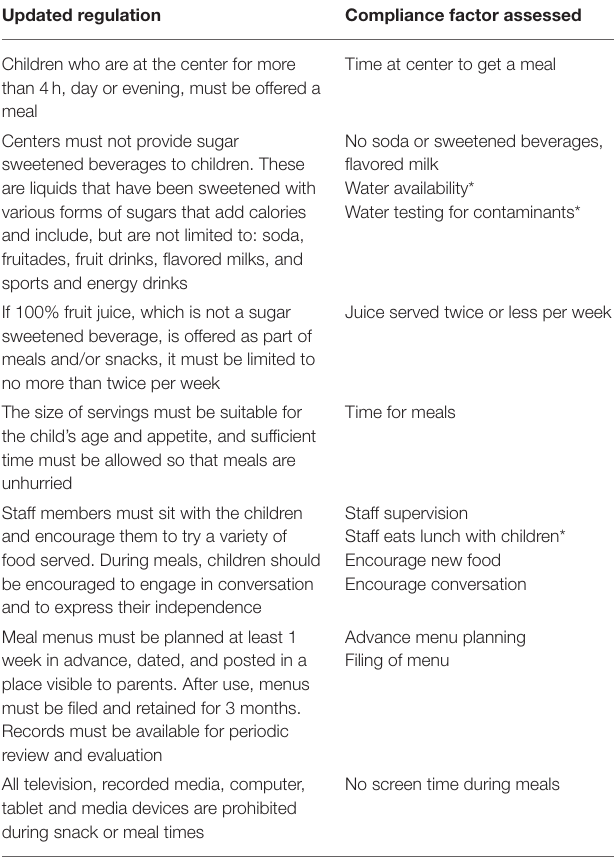
TABLE 1 | Regulation language and related compliance factor assessed in the